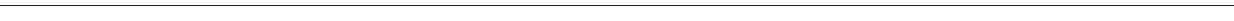
FIGURE 2 | points represent the number of oocysts in individual mosquitoes and the lines show the arithmetic mean. X-axis values are µ g/ml total IgG in the assay. The results of the two feeds are summarized in the tables. a IgG concentration ( µ g/ml) in feeder. b Arithmetic mean of oocyst intensity from 20 mosquitoes. c Percent inhibition of mean oocyst intensity and the 95% confidence interval (95% CI). d Two-sided p -values testing whether % inhibition is significantly different from zero. (C,D) The quality of the anti-Pfs25-IgG used in the SMFA was assessed by linear two regression analyses, correlating the Log10-transformed ratios of mean oocyst counts in control and test samples (log-mean ratio, LMR) with the anti-Pfs25 specific IgG level in the feeder (C) or the reciprocal dilution factor from the original serum pool (D) . LMR is plotted on the left y-axis. The right y-axis shows the correspondent %TRA. Values on the x-axis are plotted on a square root scale. The black line shows the shared linear fit for IgG from groups of mice immunized with 4 µ g Pfs25-IMX313 in Alhydrogel or with 4 µ g and 0.4 µ g of Pfs25-IMX313 in AS01. Colored lines show linear fits for individual groups. Filled and unfilled shapes show data points from two independent SMFA experiments. Data points marked with an asterisk were excluded from the analysis as they showed 100% TRA (upper plateau level of dose